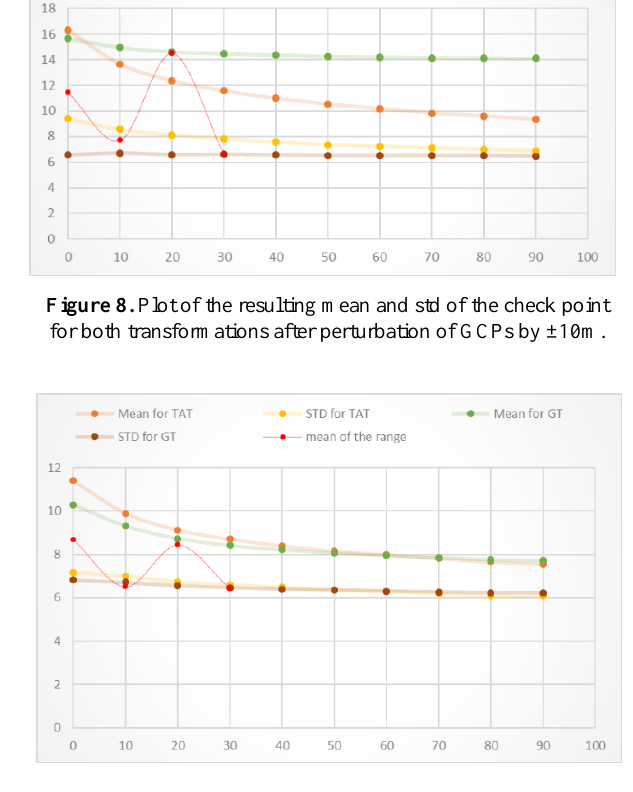
Figure 9. Plot of the resulting mean and std of the check point for both transformations after perturbation of GCPs by ±20m.